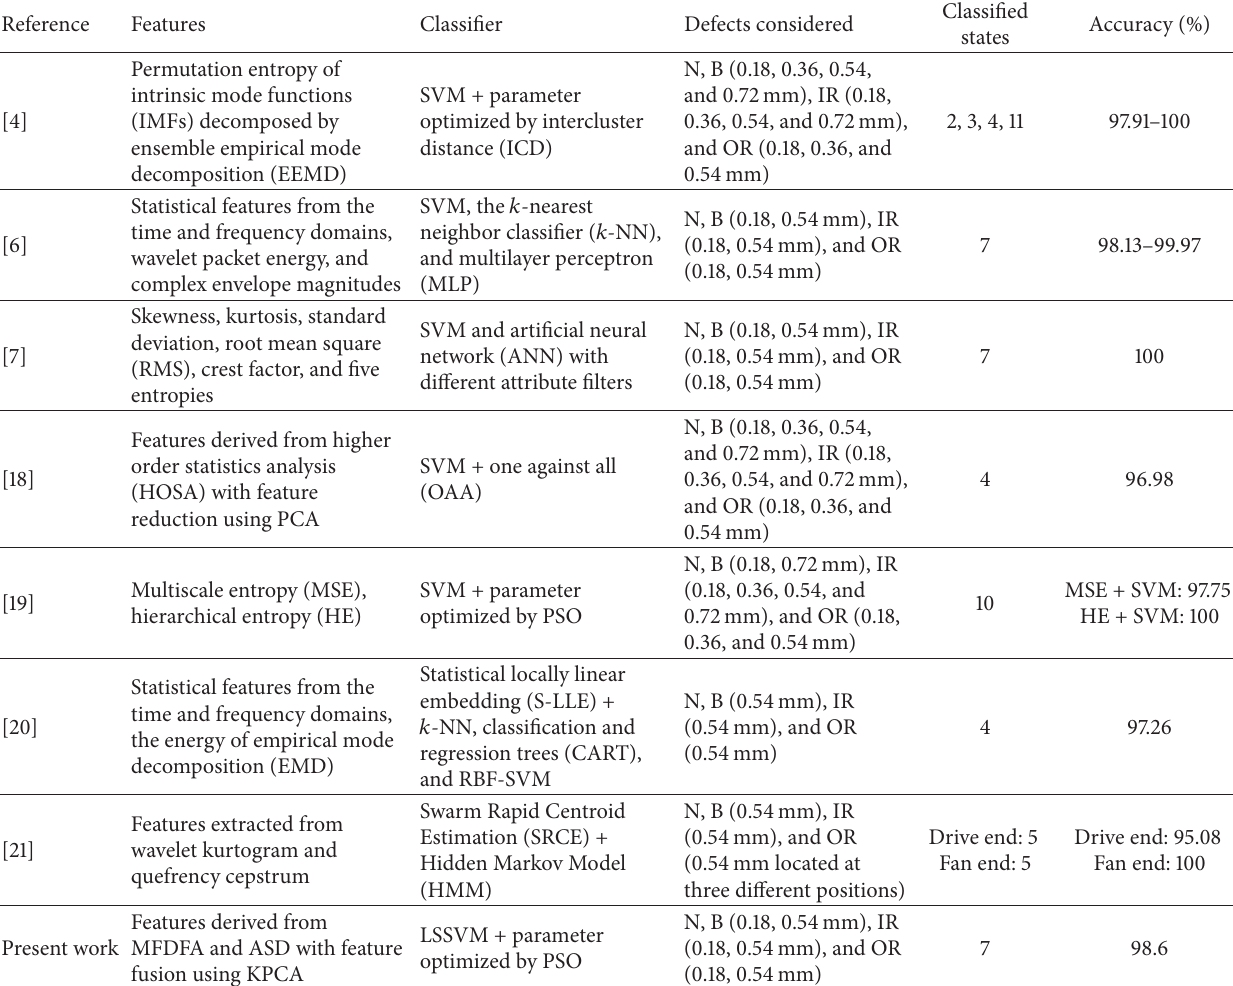
Table 6: Comparison of this work with some previous researches using CWRU bearings data